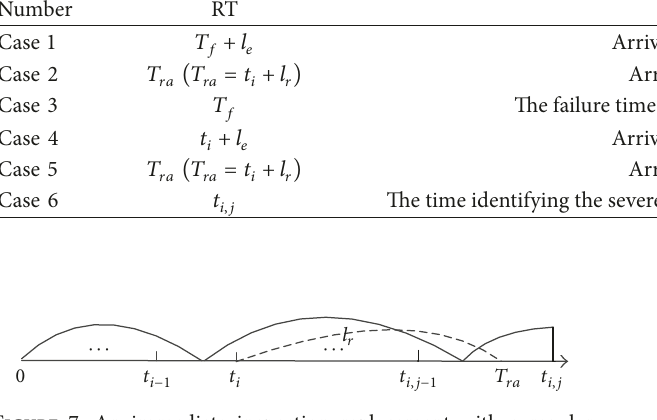
Figure 7: An immediate inspection replacement with a regular ordered